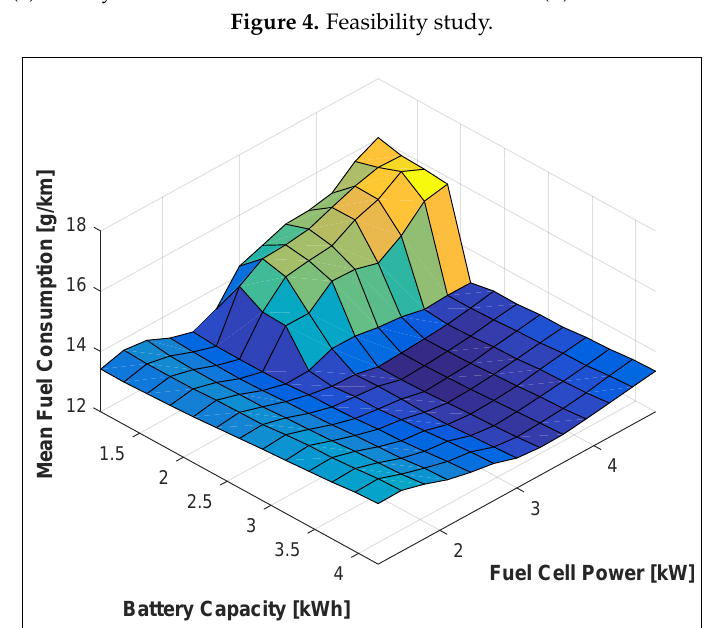
Figure 4. Feasibility study.